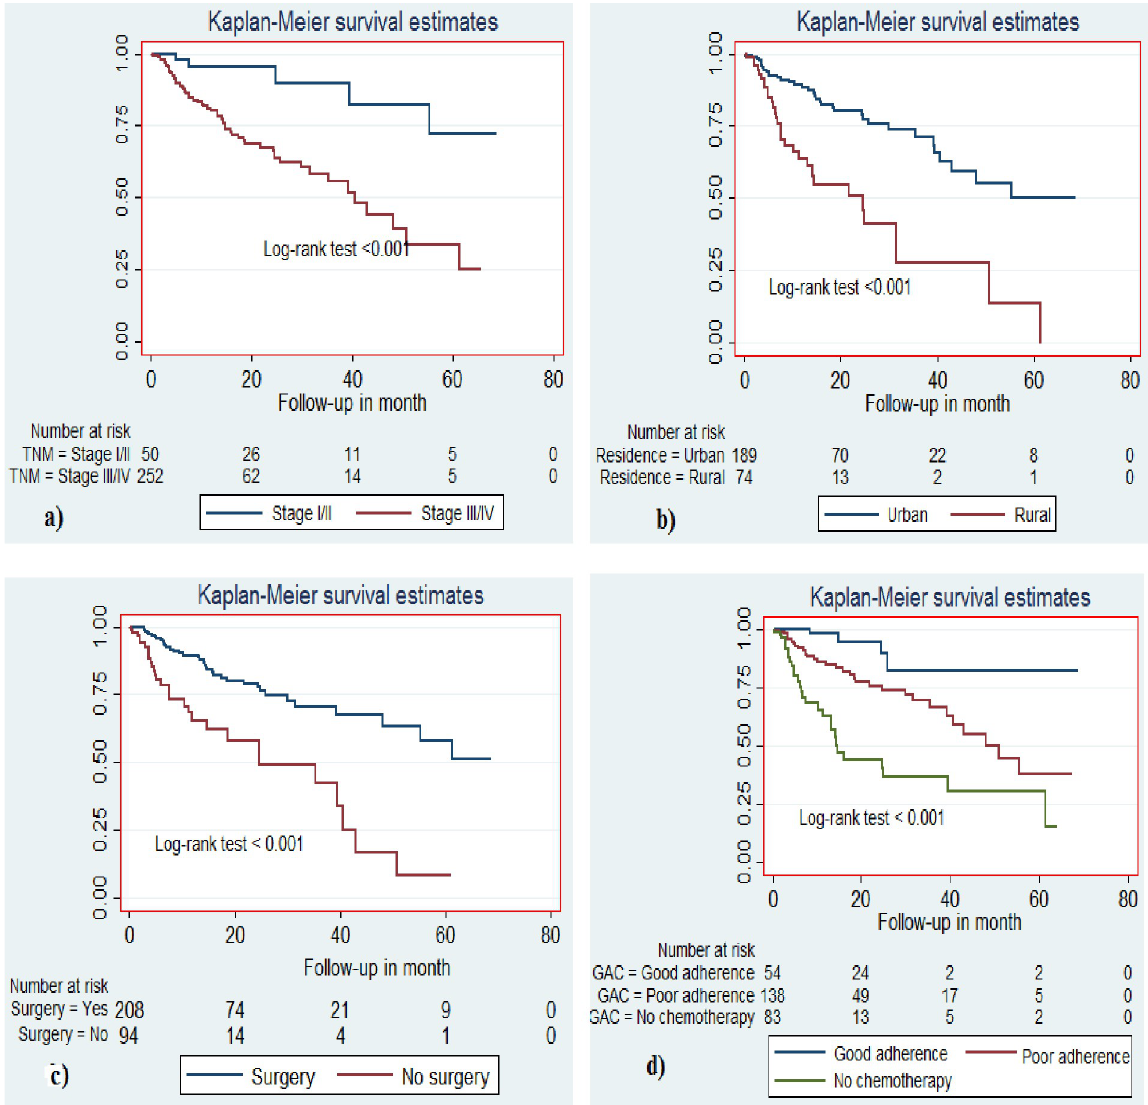
Fig 3. Kaplan-Meier survival curve among female breast cancer patients in South Ethiopia, 2013–2018. (a) for the stage of breast cancer (b) for residence (c) for surgical therapy (d) for adherence to chemotherapy.